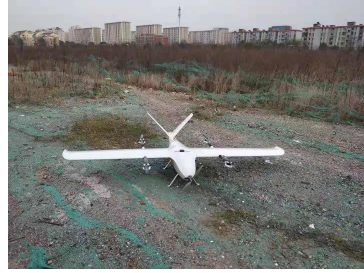
Figure 7. The experimental platform of the vertical take-off and landing (VTOL)